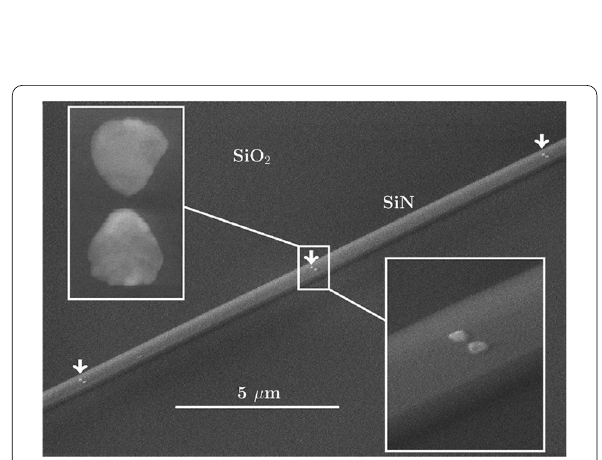
Fig. 10 Scanning electron microscope image of a functionalized waveguide. The white arrows indicate antenna positions. The insets show a zoom of a typical antenna. (Reprinted with permission from Ref. [60])